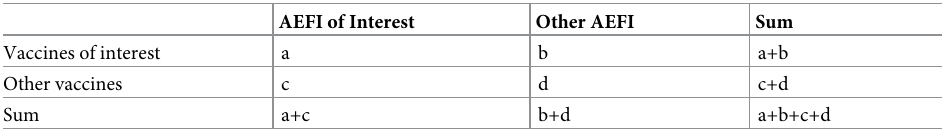
Table 1. Vaccine and adverse event 2x2 contingency